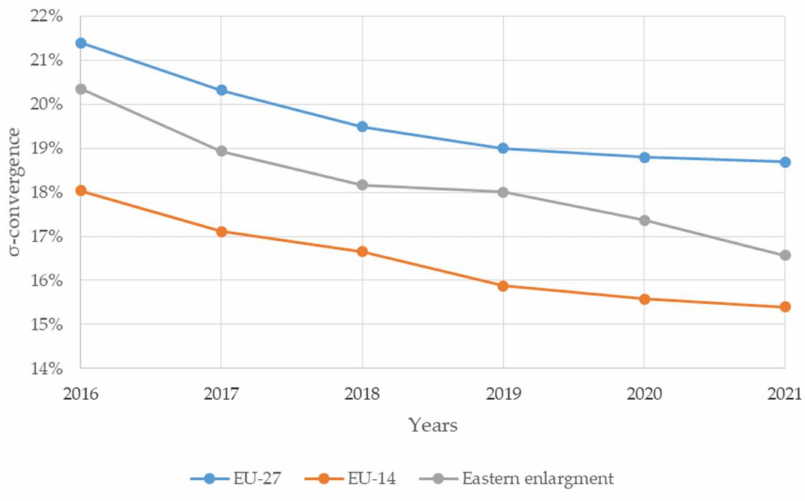
Figure 3. σ -convergence of DESI overall